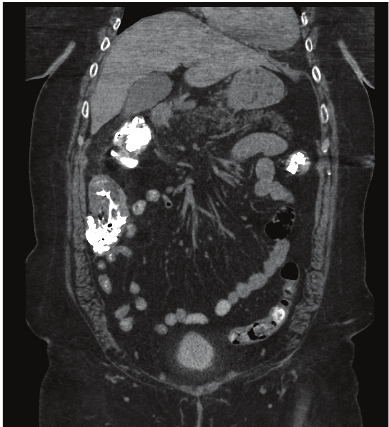
Figure 2: Focal thickening of ascending